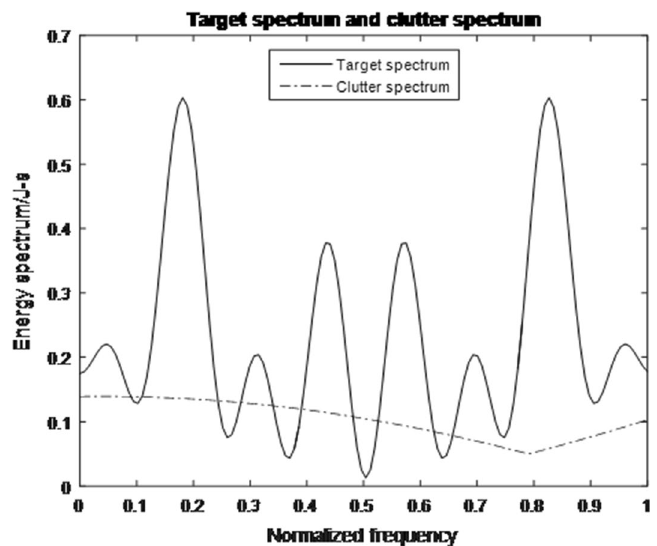
Fig. 9 Total target spectrum and clutter spectrum adopted with minmax strategy